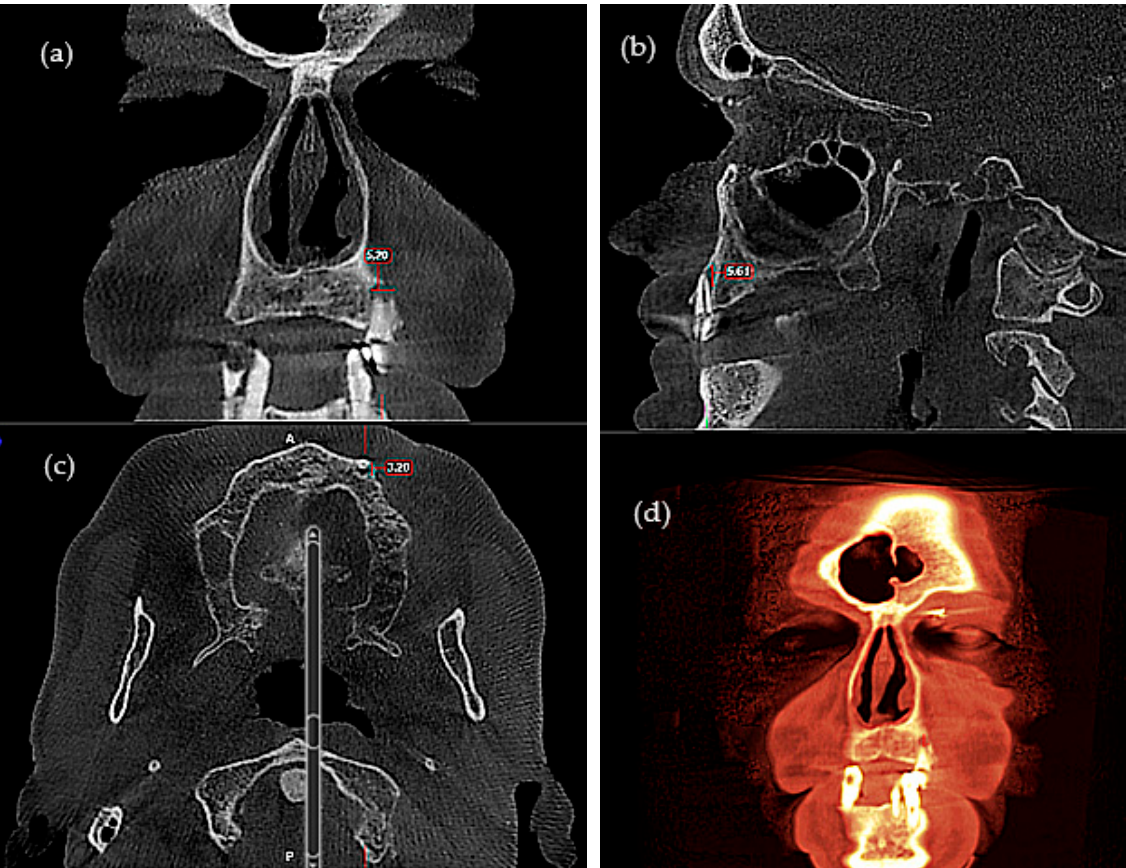
Figure 1. Orthopantomography of patient A.D., larynx cancer, 62 years old, assessment of horizontal bone loss (maximum 5.1 mm at tooth 46) and measurement of the size of periapical lesions present at tooth 23 is 3.6 mm.